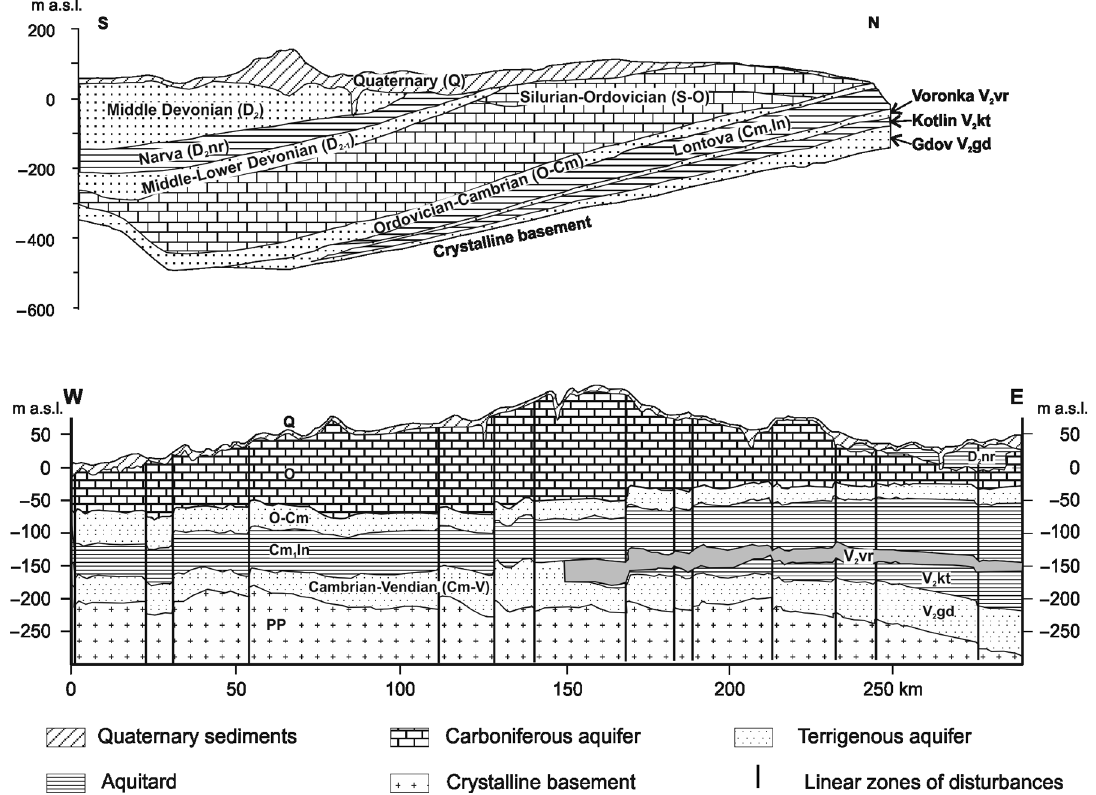
Fig. 2. Hydrogeological cross sections (SN and WE) of the Cambrian(cid:150)Vendian aquifer system (CVAS) in northern Estonia. Lines of cross sections shown in Fig. 1. The investigated part of the CVAS is marked with grey colour on the WE cross